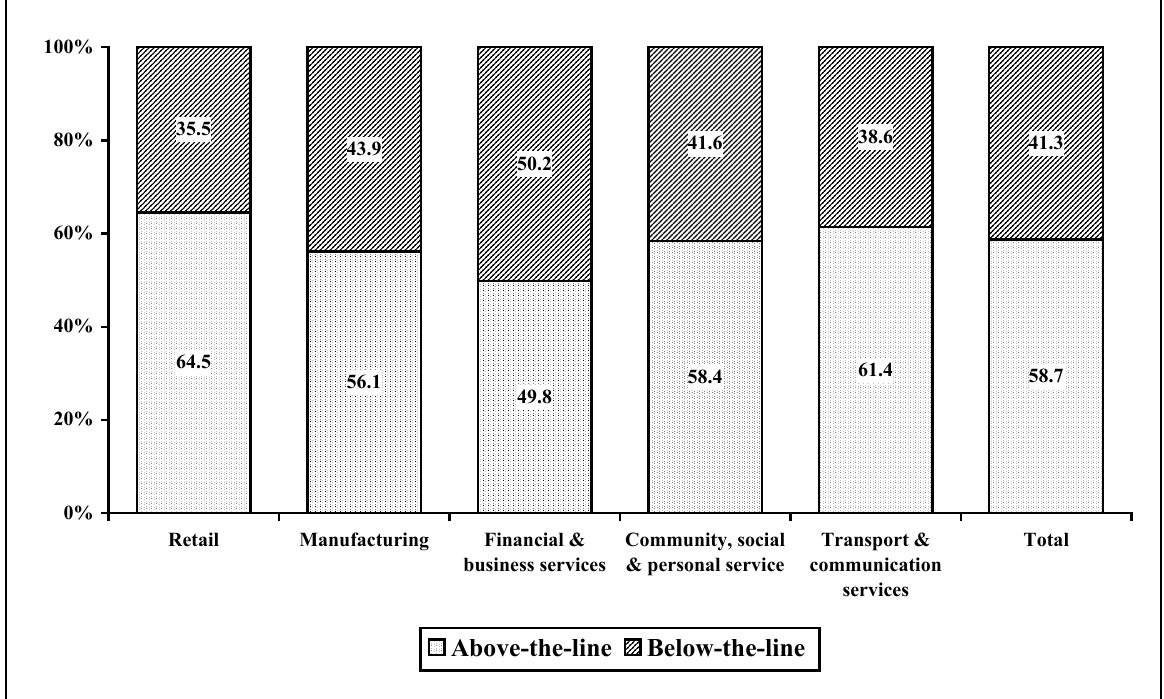
Figure 2 Composition of advertising and promotion expenditure in South Africa by economic